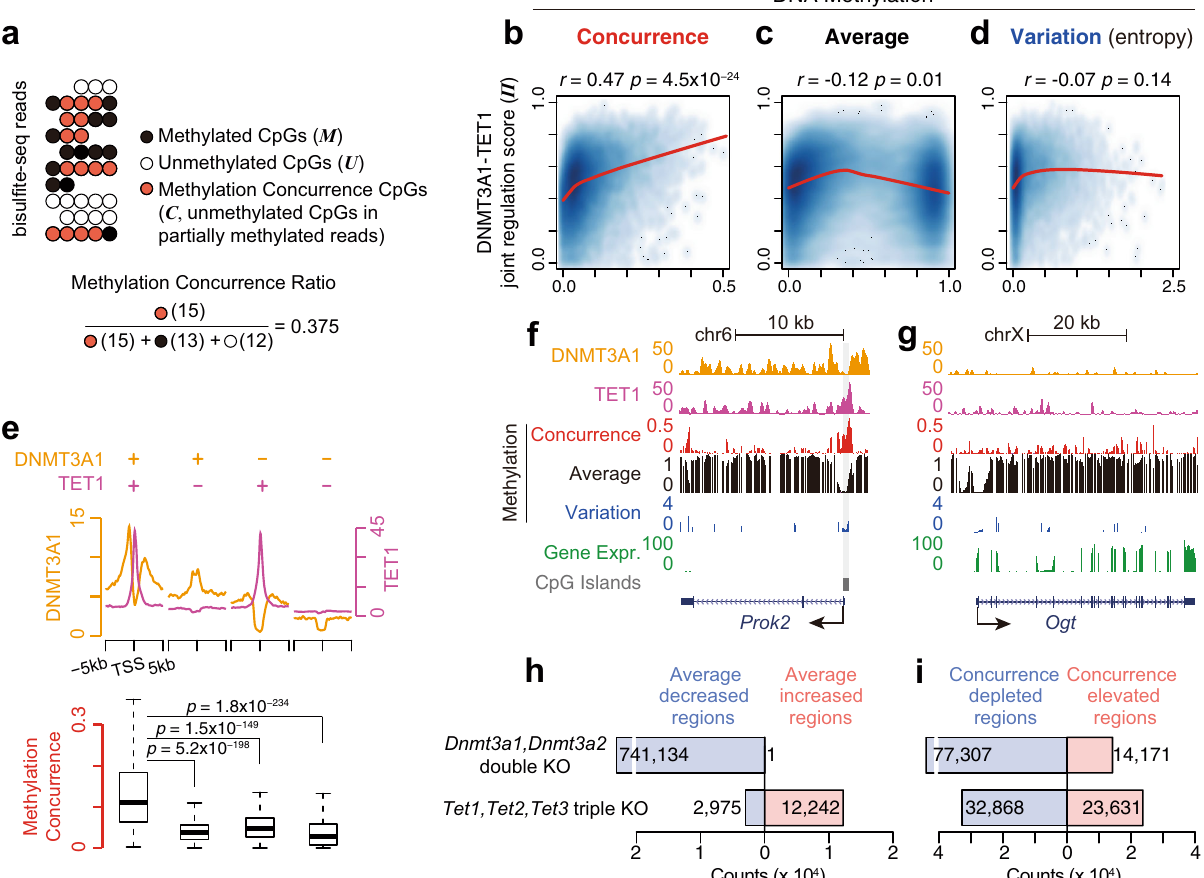
Fig. 1 The methylation concurrence ratio measures the antagonism between methylation and demethylation processes in mESCs. a Schematic of DNA methylation concurrence captured by bisul fi te-seq. Solid circles are methylated cytosines. Blank circles are unmethylated cytosines. Red circles are unmethylated cytosines in partially methylated reads, i.e., methylation- concurrence cytosines. The equation below shows the calculation of methylation concurrence ratio using the example above. b Methylation concurrence is positively correlated with the ‘ DNMT3A1-TET1 joint regulation score ’ ( Π ) in gene promoter regions. Average methylation ( c ) and methylation variation ( d ) are not correlated with Π at gene promoters. Spearman ’ s rank correlation was calculated. P values were calculated by the two-tailed correlation test for Spearman ’ s correlation. LOWESS lines were plotted to describe the relationships between variables (indicated by red curves). e The methylation concurrence ratio is signi fi cantly higher at DNMT3A1&TET1 co-occupied promoters. Gene numbers of each groups: ‘ DNMT3A1 + TET1 + ’ , n = 1294; ‘ DNMT3A1 + TET1 − ’ , n = 1238; ‘ DNMT3A1 − ;TET1 + ’ , n = 1370; ‘ DNMT3A1 − TET1 − ’ , n = 1595. The two-tailed Mann – Whitney U test was used for the signi fi cance test. The line in the box center refers to the median, the limits of box refer to the 25th and 75th percentiles and whiskers are plotted at the highest and lowest points within the 1.5 times interquartile range. f UCSC Genome Browser tracks show DNMT3A1 binding (orange), TET1 binding (purple), methylation concurrence (red), average methylation (black), methylation variation (blue), and gene expression data (green) at Prok2 gene. CpG islands are shown in gray. g Same as ( f ), but for gene Ogt . h Dnmt3a knockout leads to a decrease in average methylation, while Tet knockout leads to hypermethylation. i Both Dnmt3a knockout and Tet knockout lead to more concurrence depletion than elevation. According to the original paper, the ‘ Dnmt3a1 , Dnmt3a2 double knockout ’ sample is generated by reintroducing DNMT3B1 into stem cells that lack DNA methylation due to deletions of all Dnmt genes ( Dnmt3a1, Dnmt3a2 , and Dnmt3b1 ). The genomic binding of the reintroduced DNMT3B1 in knockout cells resembles that in wild-type ES cells 22